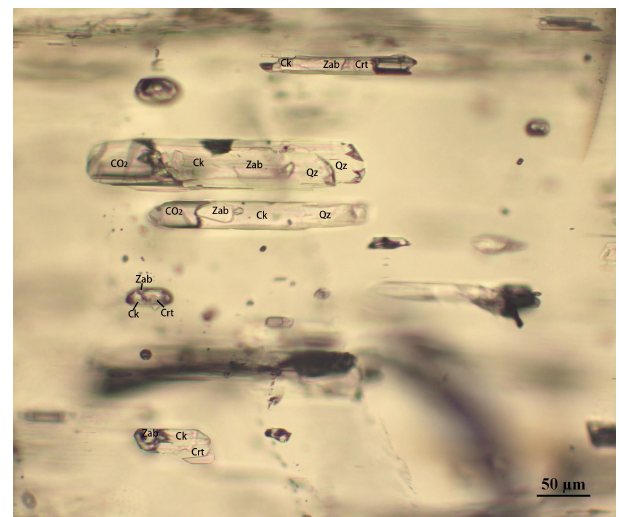
Figure 1. Photomicrographs of spodumene-hosted crystal-rich in- clusions (CIs) in the Jiajika deposit, showing one fluid inclusion assembly (FIA) of CIs with a uniform composition and the crys- tal/fluid proportion. Crt – cristobalite; Spd – spodumene; Zab – zabuyelite; Cal – calcite, Qz – quartz; Ck –